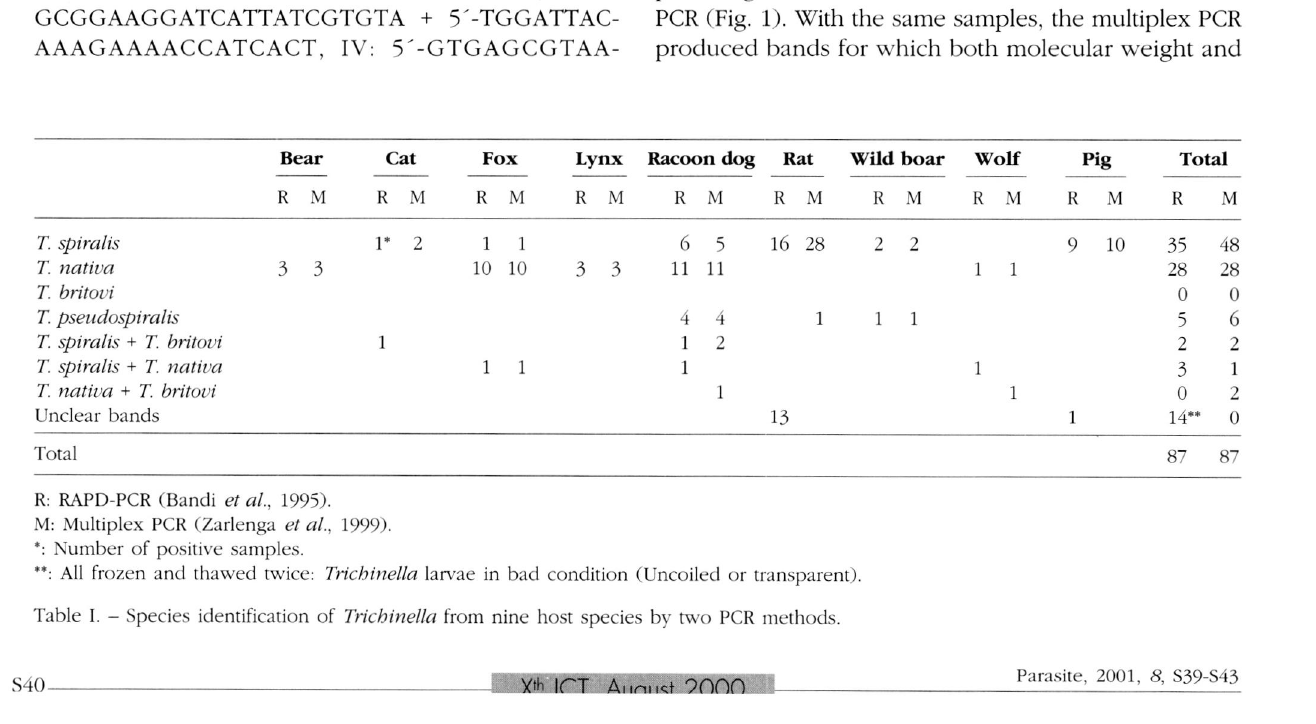
Table I. - Species identification of Trichinella from nine host species by two PCR methods.